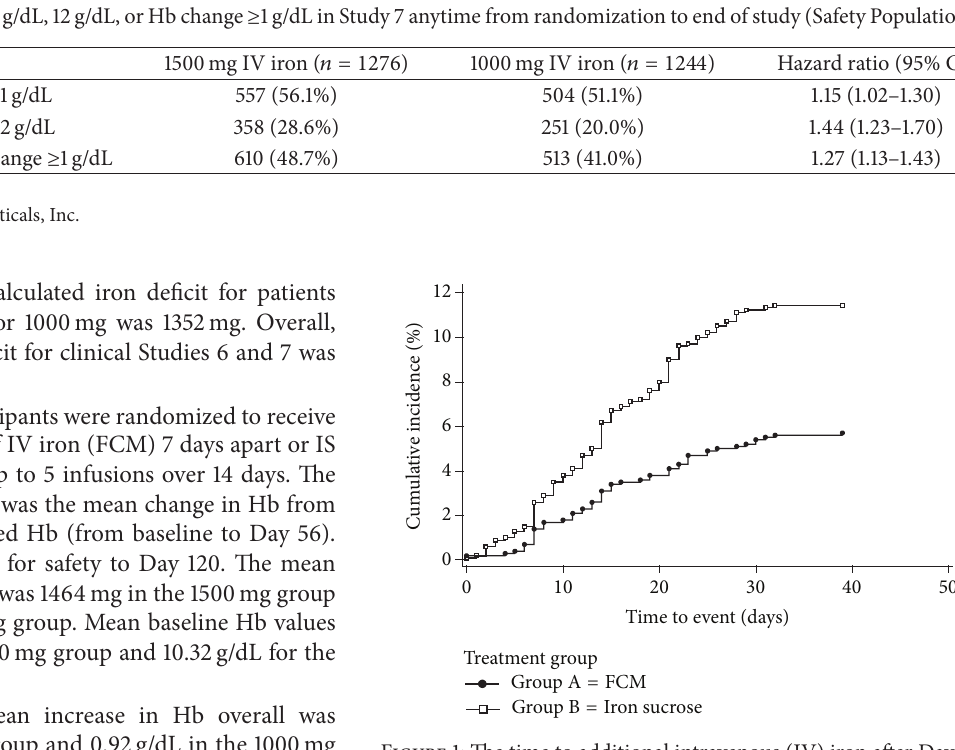
Figure 1: The time to additional intravenous (IV) iron after Day 56 comparing 1500mg to 1000 mg IV iron in the Safety Population of Study 7. Data on file, Luitpold Pharmaceuticals,